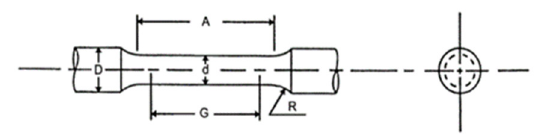
Figure 1. Schematic representation of specimen position in casting.